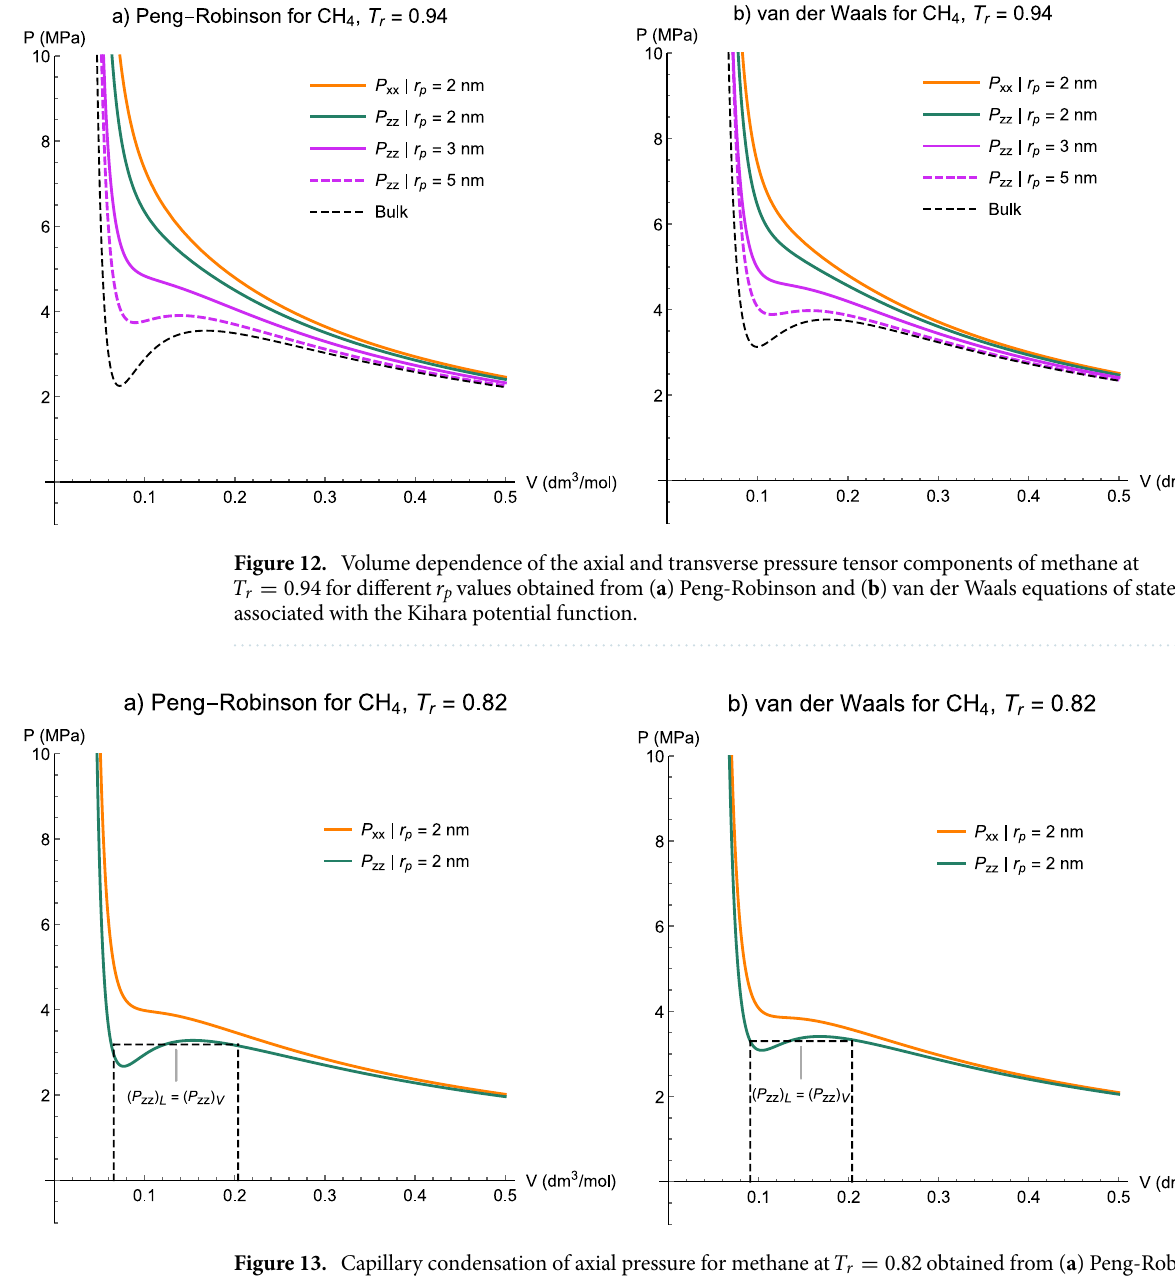
Figure 13. Capillary condensation of axial pressure for methane at T r and ( b ) van der Waals equations of state associated with the Kihara potential function. Dashed line evidence the Maxwell construction for two-phase